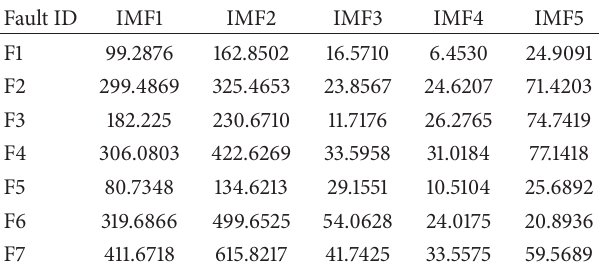
Table 5: MPDF values of IMFs